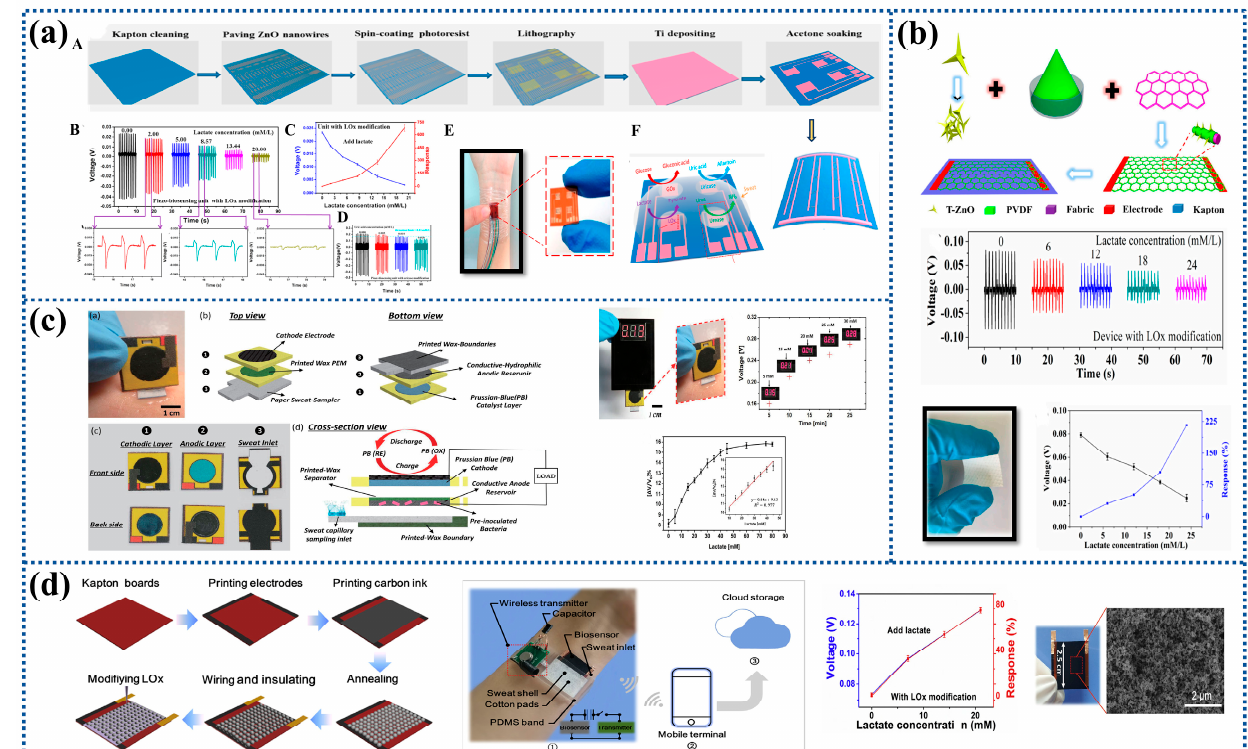
Figure 7. Preparation process and characterization of self − powered biosensors for lactate detection: ( a ) A self − powered piezoelectric biosensor based on enzyme/ZnO nanoarrays. (A) The fabrication process of the electronic skin. (B) The pie- zoelectric impulse of the piezoelectric biosensor. (C) The piezoelectric output voltage and response of the piezoelectric biosensor in different concentration of lactate. (D) The detection limit and the resolution of the piezoelectric lactate bio- sensor. (E) Optical images of the electronic skin. (F) The electronic skin for detecting lactate. Reprinted with permission